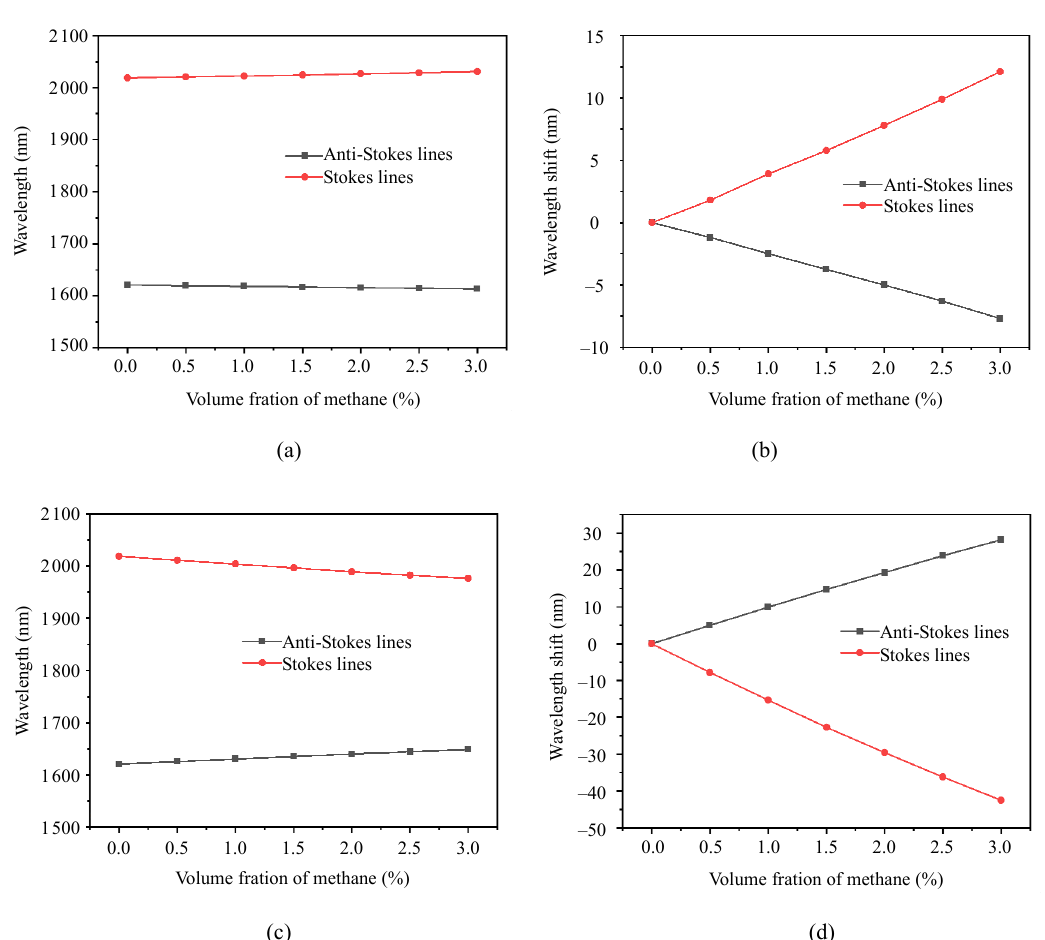
Fig. 10 Stokes and anti-Stokes peak wavelength shift curves and sensitivity fitting affected by gas concentrations under optimal parameters: (a) peak wavelength shift curves and (b) sensitivity fitting curves with methane concentrations; (c) peak wavelength shift curves and (d) sensitivity fitting curve with hydrogen